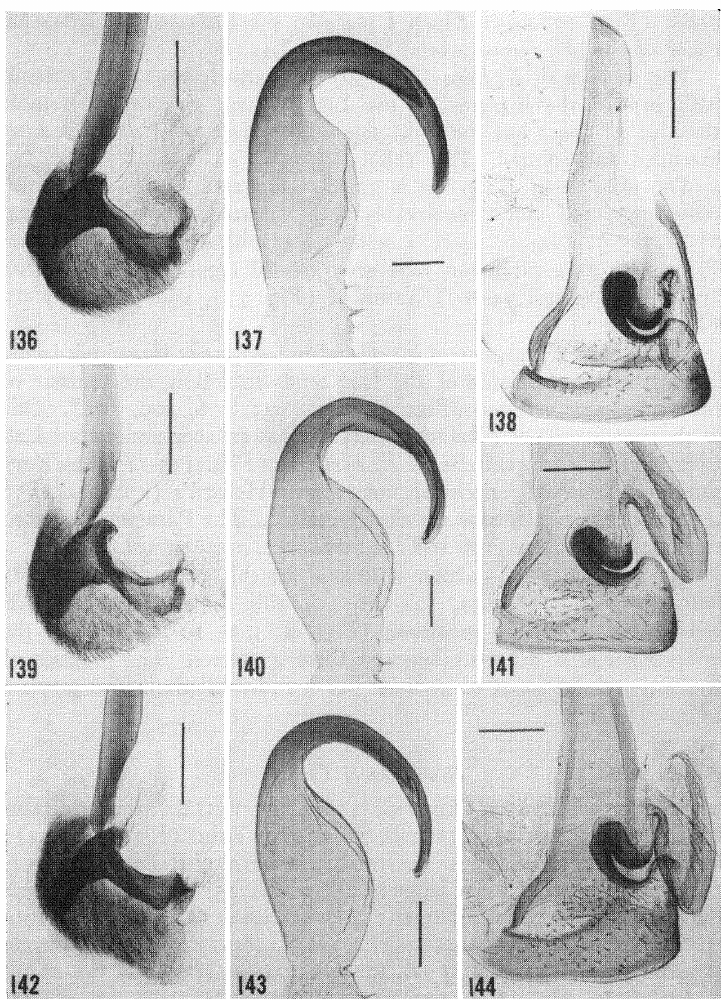
Figs. 136-144. Cockroach male genitalia. Eilamlra quisqueiana. Para- types. 136-138. (37 JkNSP). 139-141. (84 ANSP). San Lorenzo, Province o Samanfi, Dominican Republic, Hispaniola. 142-144. (82 ANSP). San Francisco Mountains, Province o Santo Domingo, Dominican Republic. (scale 0.2